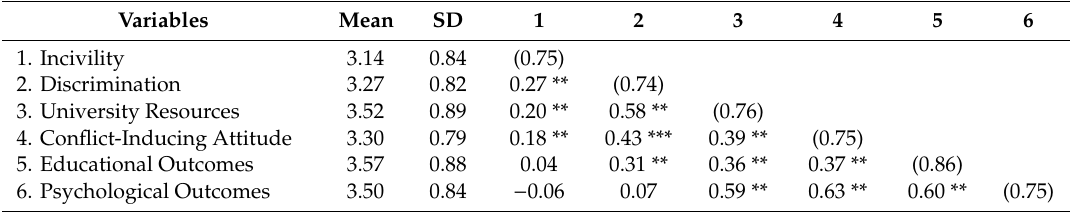
Table 4. Correlation matrices for path